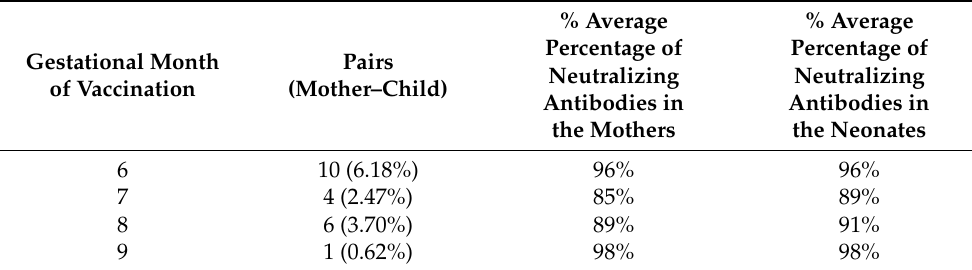
The existing relationship between the percentage of neutralizing maternal and neonatal antibodies was observed, resulting in a Pearson’s correlation coefficient equal to 0.95 and demonstrating that as the average maternal antibody level increases, the average antibody level of the neonates also tends to increase (Figure 1).